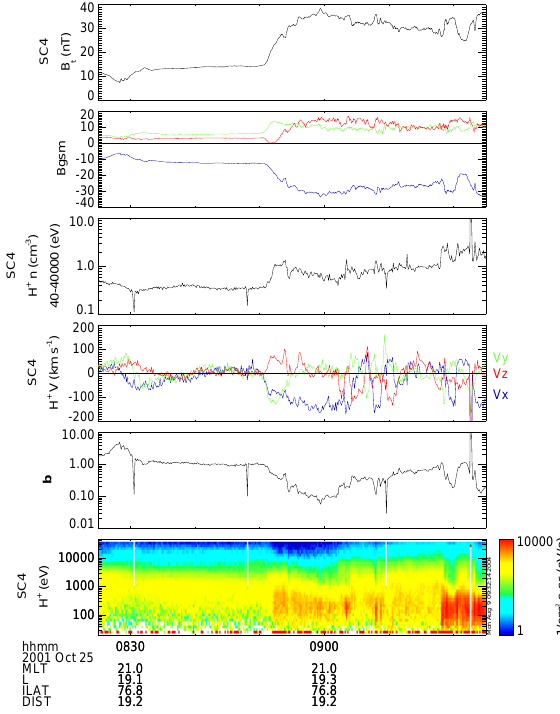
Fig. 16. Cluster FMG and CIS data during an SI event observed on 25 October 2001. The panels show magnetic field magnitude, magnetic field GSM components ( B x : blue, B y : green, B z : red), H + density, components of the velocity, plasma beta and the H +